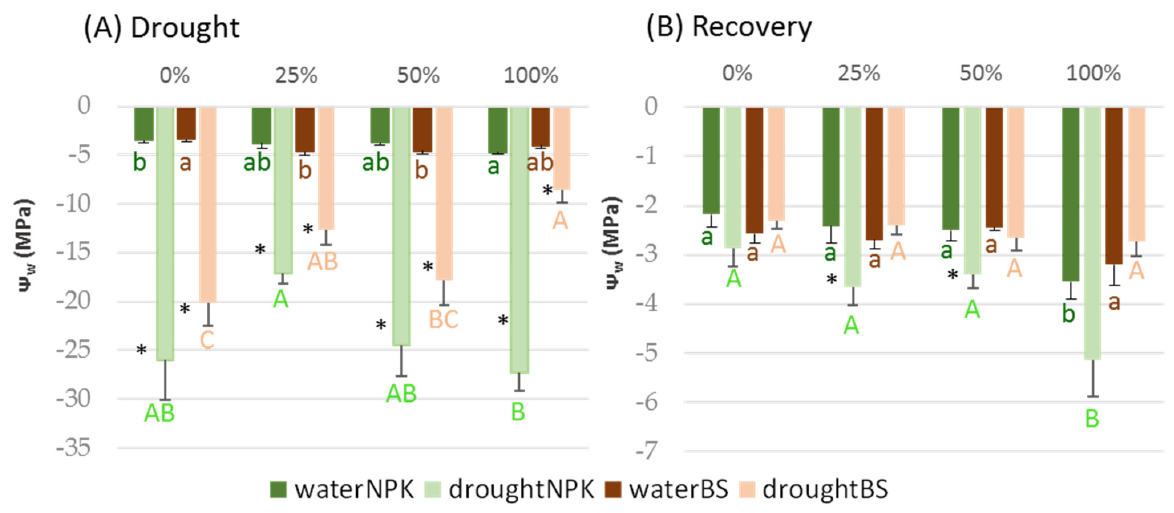
Figure 5. Water potential values of chestnut plants cultivated with the different substrate mixtures (compost: 0%, 25%, 50% and 100%) after one week of drought ( A ) and after one week of irrigation restoration ( B ). Within each substrate mixture, the green bars show the values of NPK-treated plants (irrigated dark bars, and subjected to drought light bars) and the brown bars show the values of BS-treated plants (irrigated dark bars, and subjected to drought light bars). Letters (green lowercase letters for irrigated NPK-treated, green uppercase letters for drought NPK-treated, brown lowercase letters for irrigated BS-treated and brown uppercase letters for drought BS-treated) indicate significant differences ( p < 0.05; n = 6) between substrate mixtures for each situation (irrigation or drought) and within each treatment (NPK or BS). Asterisk means significant differences using t -tests between water and drought within each substrate mixture and treatment (NPK or